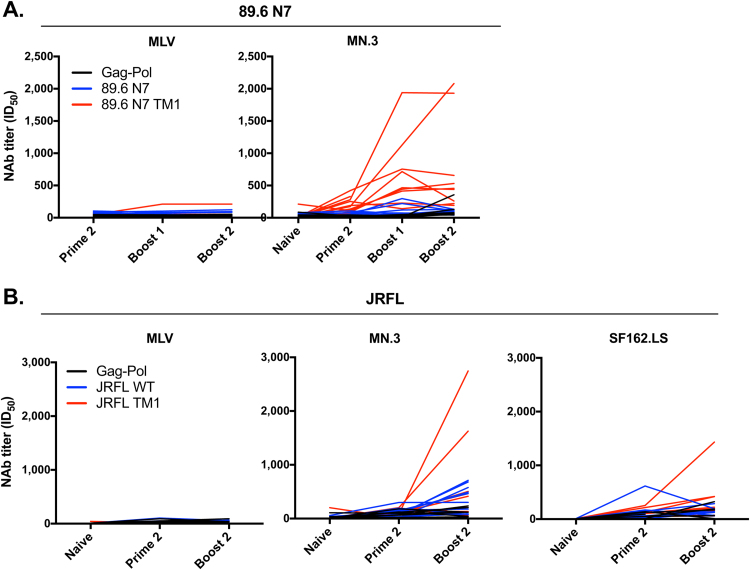
Distribution of HIV-1 NAb responses and low non-specific activity. The data reflect the same assays as Fig. 6 but are shown for individual animals without subtracting non-specific neutralizing activity quantified using a murine leukemia virus (MLV) Env pseudovirus. NAb titers are shown for MLV and HIV-1 strains MN.3 and SF162.LS for 8–10 mice per group in (A) 89.6 N7 and (B) JRFL Env immunizations. Statistical analysis of background-corrected data is shown in Fig. 6.